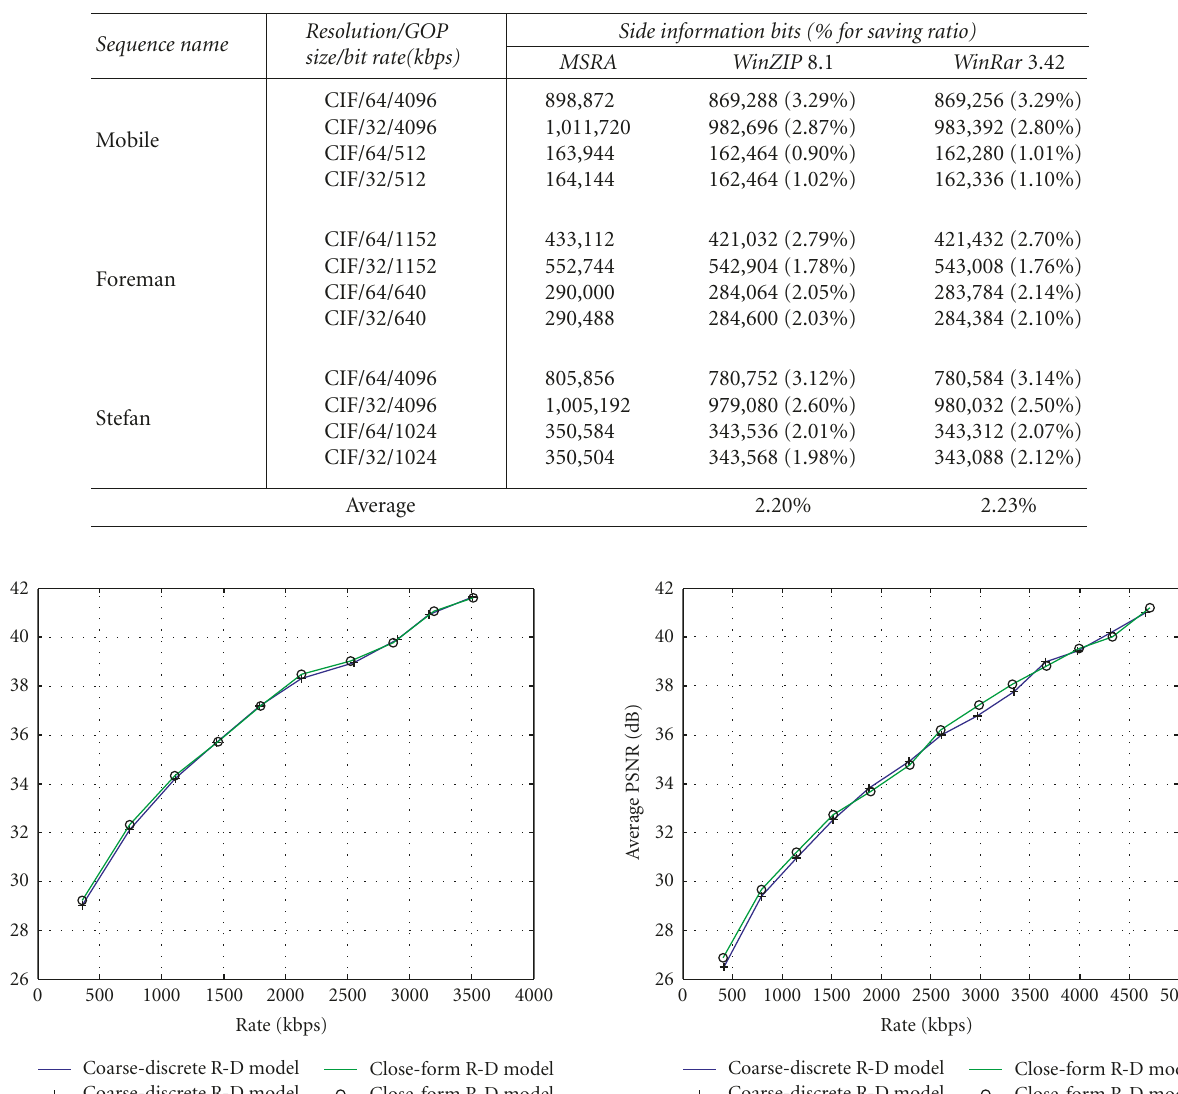
Table 4: Lossless compression of side information.